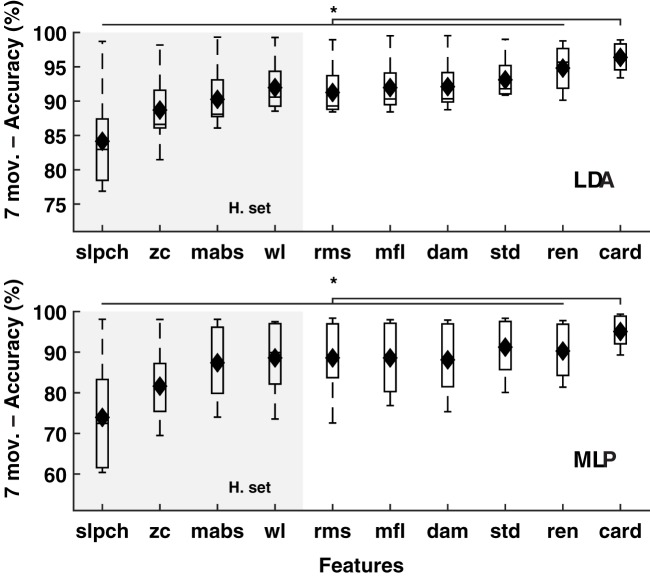
MPR accuracy of seven movements using single EMG features. Accuracy of myoelectric pattern recognition (MPR) of seven movements (20 subjects, IM data) using single EMG features. The LDA and MLP classifiers were employed (upper and lower insets, respectively). Cardinality outperformed previously known features, including the features from the Hudgins set (H. set). The dynamic part of the contraction was included during signal processing (cTp = 0.7). The marker “*” represents statistical significance at p < 0.01.